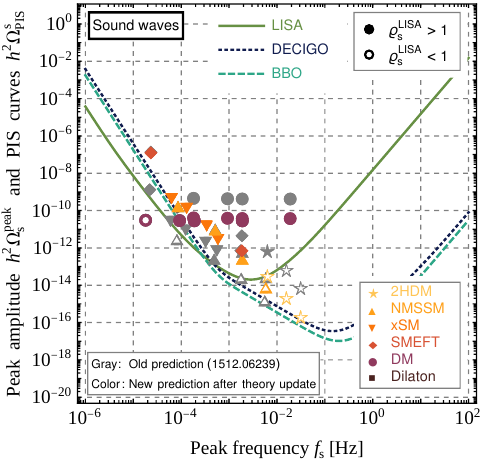
Figure 8 . Update of the benchmark points in ref. [24] according to refs. [34, 160, 161]. See text. RP phase transitions in table 1 should either be ignored or replaced by an equivalent NP phase